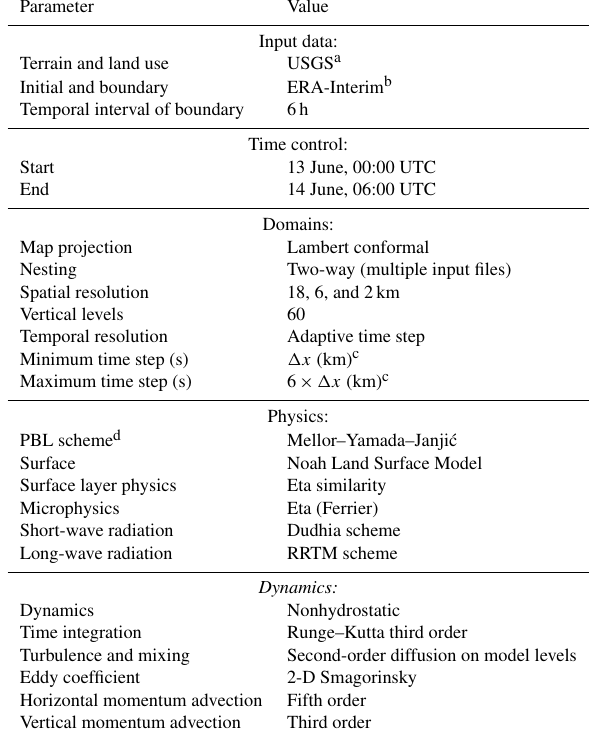
Table 1. WRF-ARW